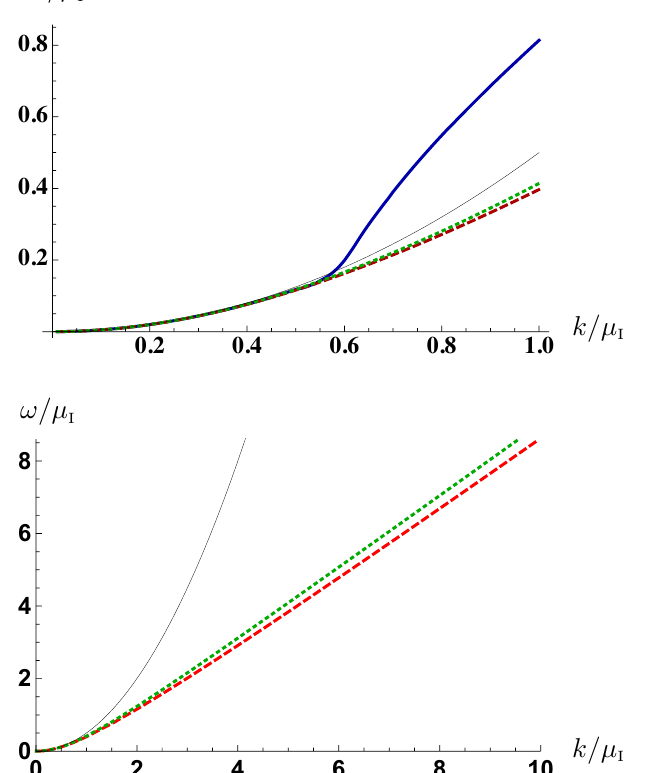
Figure 3. Dispersion relation of the Goldstone bosons for (cid:3) =M (cid:3) =M = 1 (dashed, red curve), and (cid:3) =M q (bottom) momenta. The thin black line corresponds to the low-momentum behavior (3.12) and we have set L = 1 in this